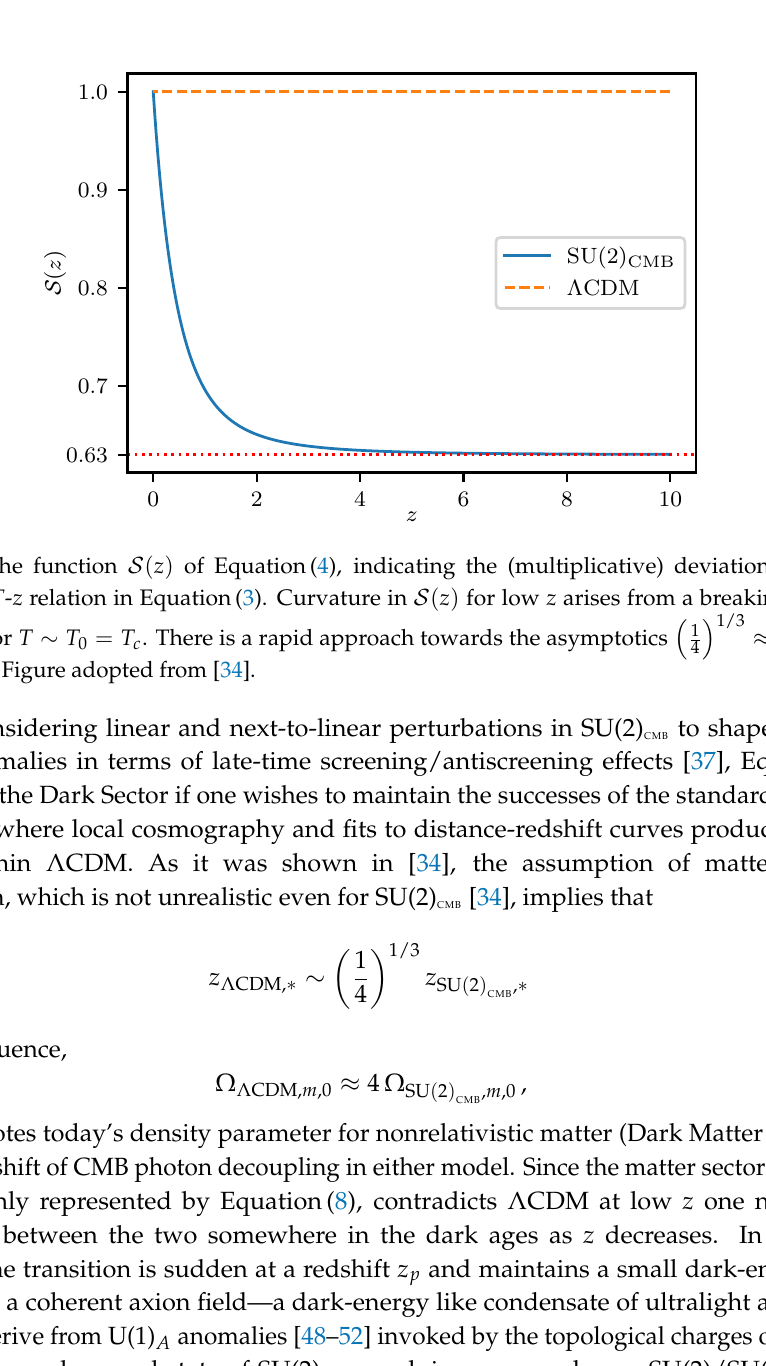
( z ) for low z arises from a breaking of scale S